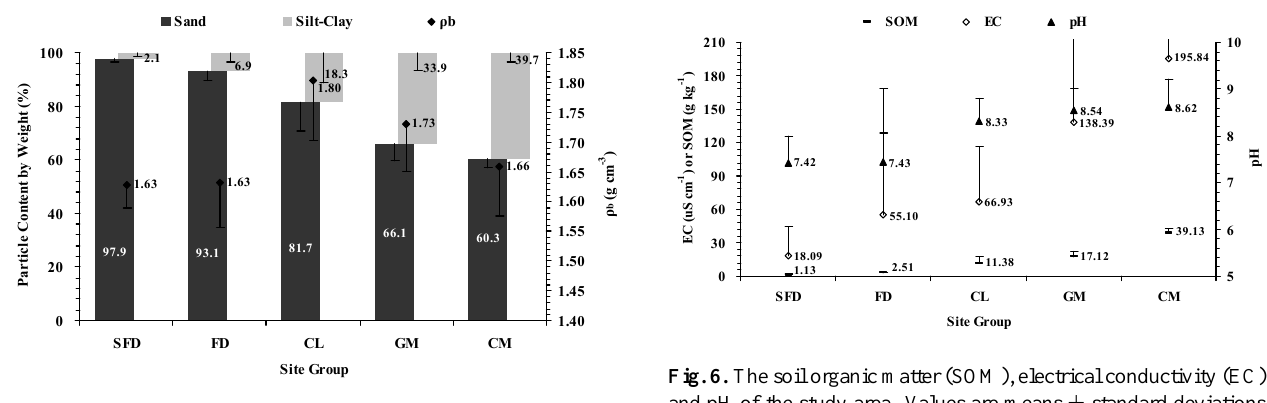
Fig. 5. The sand and silt-clay contents and bulk density ( ρ b ) of the study area. Values are means ± standard deviations. SFD stands for semi-fixed dune sites, FD for fixed dune sites, CL for cultivated land sites, GM for general meadow sites, and CM for control meadow sites where there was no detectable erosion and sand accumulation.